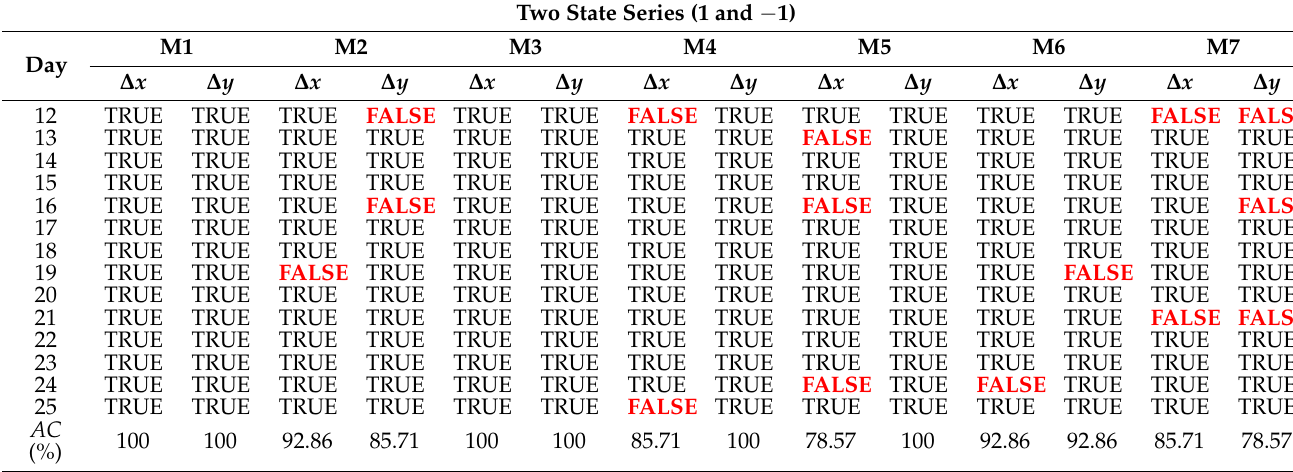
Table 21. Accuracy of AR(10) model for all markers separately–the first difference. Two State Series (1 and − 1)